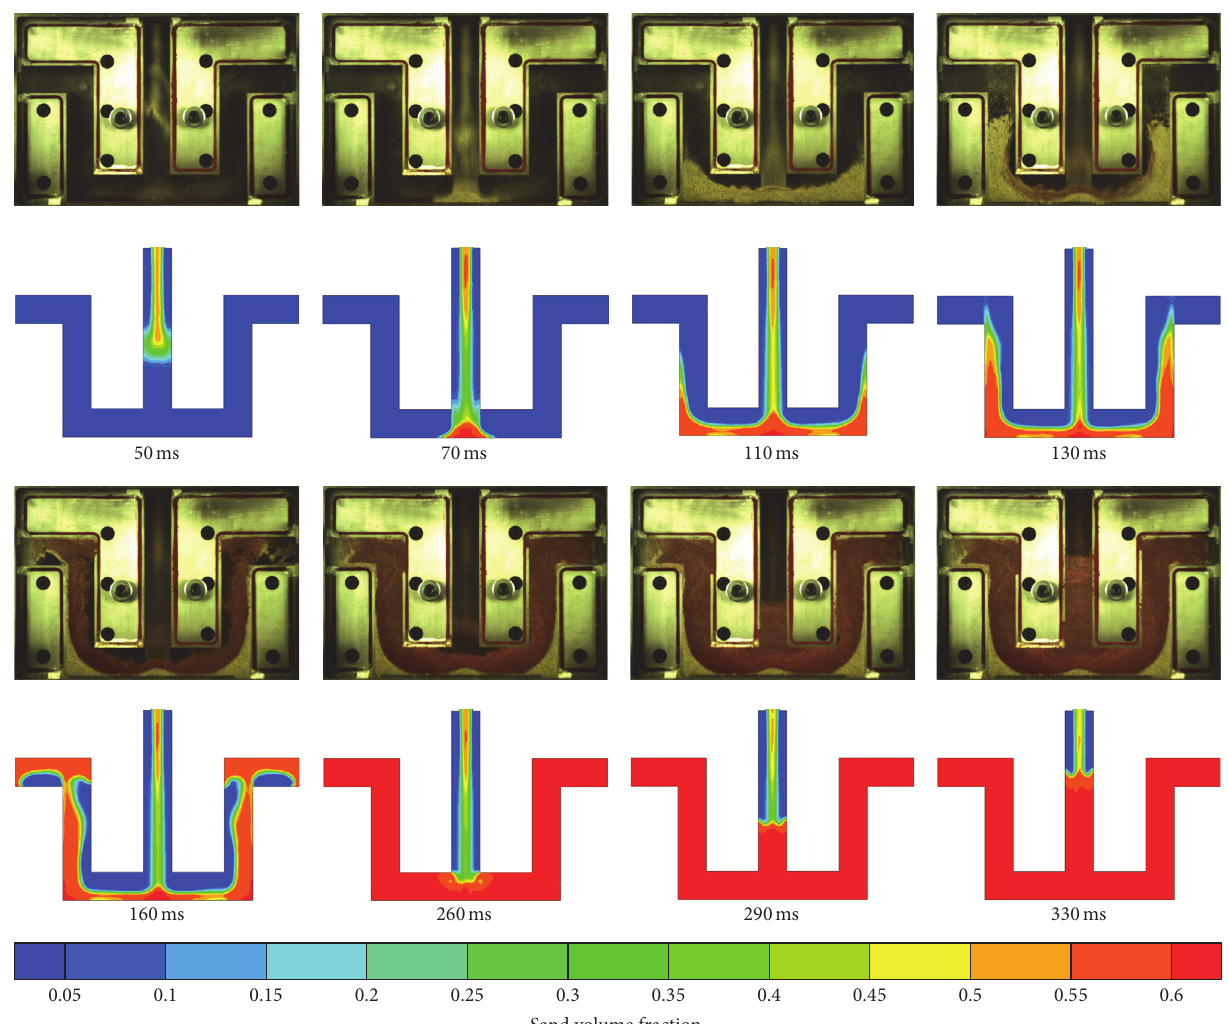
Figure 5: Comparison of simulated maps of sand volume fraction with experimental photo